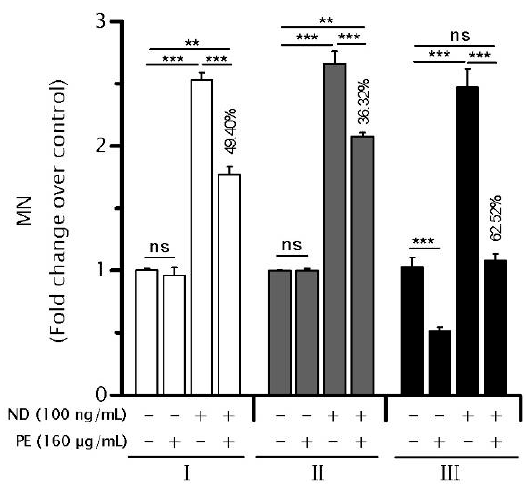
Figure 6. P. emblica (PE) treatment protected against nocodazole-induced micronuclei (MN) in NCM460 cells. NCM460 cells were either co-treated with PE and nocodazole (ND) for 6 h (I) or pre-treated with PE for 6 h (II) and 72 h (III) before a 6-h ND challenge. Cells were then allowed to recover for 1 h before cytochalasin B was added to block cytokinesis (10 h) for MN assessment. MN assessment obtained from more than 1000 binucleated cells and then were set relative to the values measured in untreated control cells, which were arbitrarily set at 1. Similar results were observed in three independent experiments. The numbers above bars indicate the percentages of reduction in ND-induced MN caused by PE from each experimental scheme calculated using the formula described in Materials and Methods. The symbols + and − represent cells were treated with or without indicated components, respectively. Error bars indicate one SEM. ** p < 0.01; *** p < 0.001 vs. untreated control. ns, not significant.